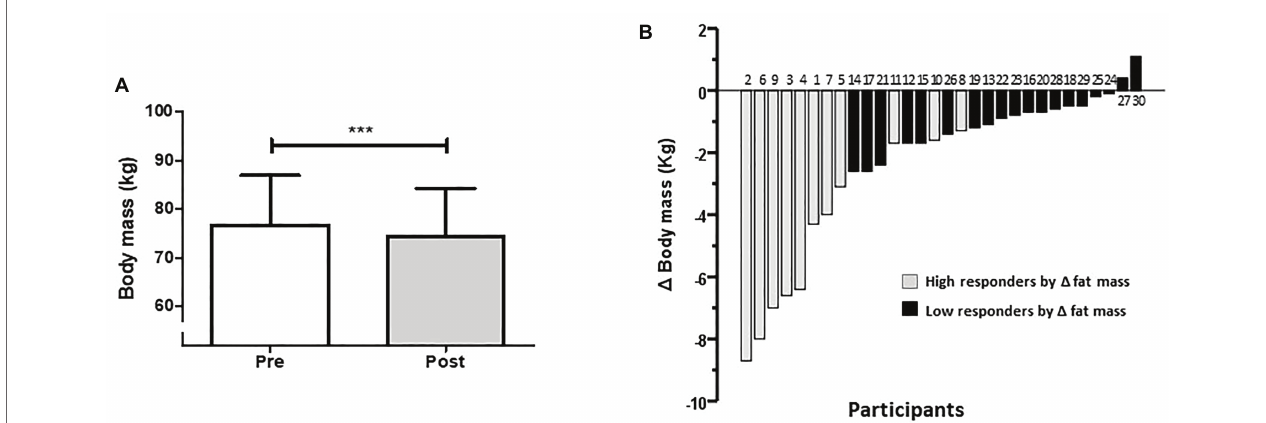
FIGURE 3 | Average changes (A) and individual response (B) to decrease body mass after the 12-week intervention. Subjects with a high or low response to reduce their fat mass are represented with gray and black bars, respectively. Numbers on the bars (B) represent the order of magnitude in the individual response to reduce fat mass. High and low responders are identified in relation to the ability to reduce fat mass. *** p <